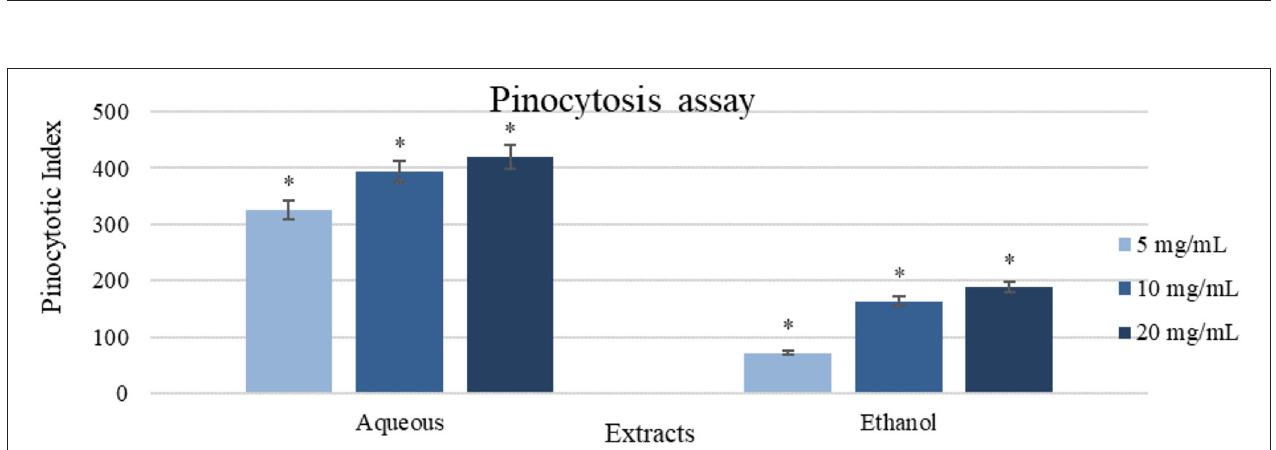
FIGURE 5 | A phagocytic assay of peritoneal macrophage treated with the aqueous and ethanol extracts (5-20 mg/ml). Results were represented as mean (bars) ± SEM (lines), ( n = 3). * P < 0.05 (statistically significant).